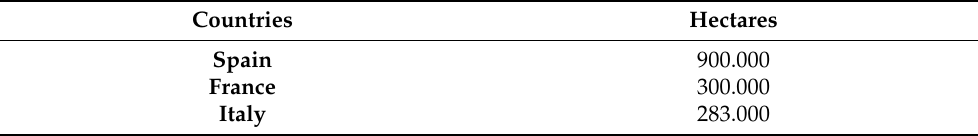
Table 1. Diffusion of conservation agriculture in some Mediterranean countries